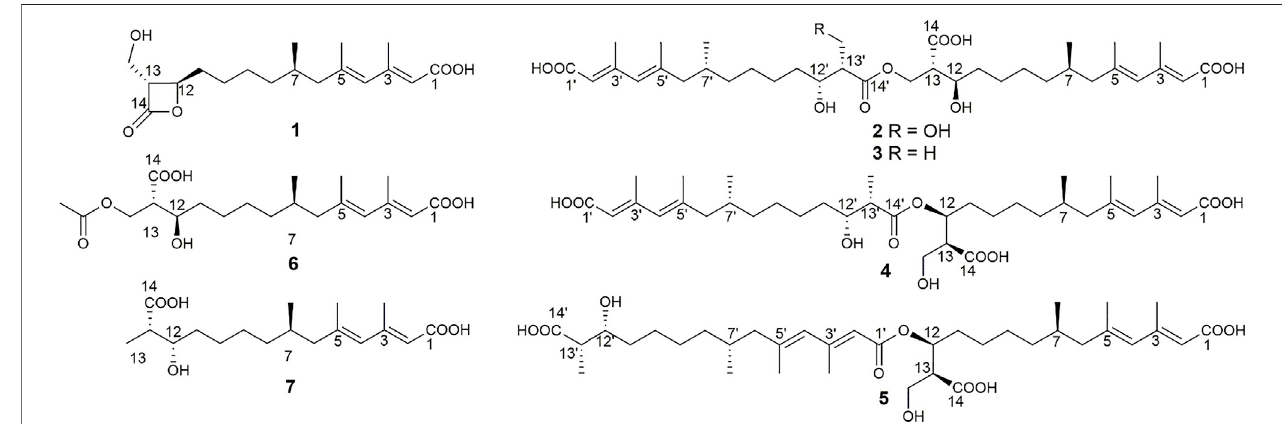
FIGURE 1 | Chemical structures of compounds 1 ‒ 7